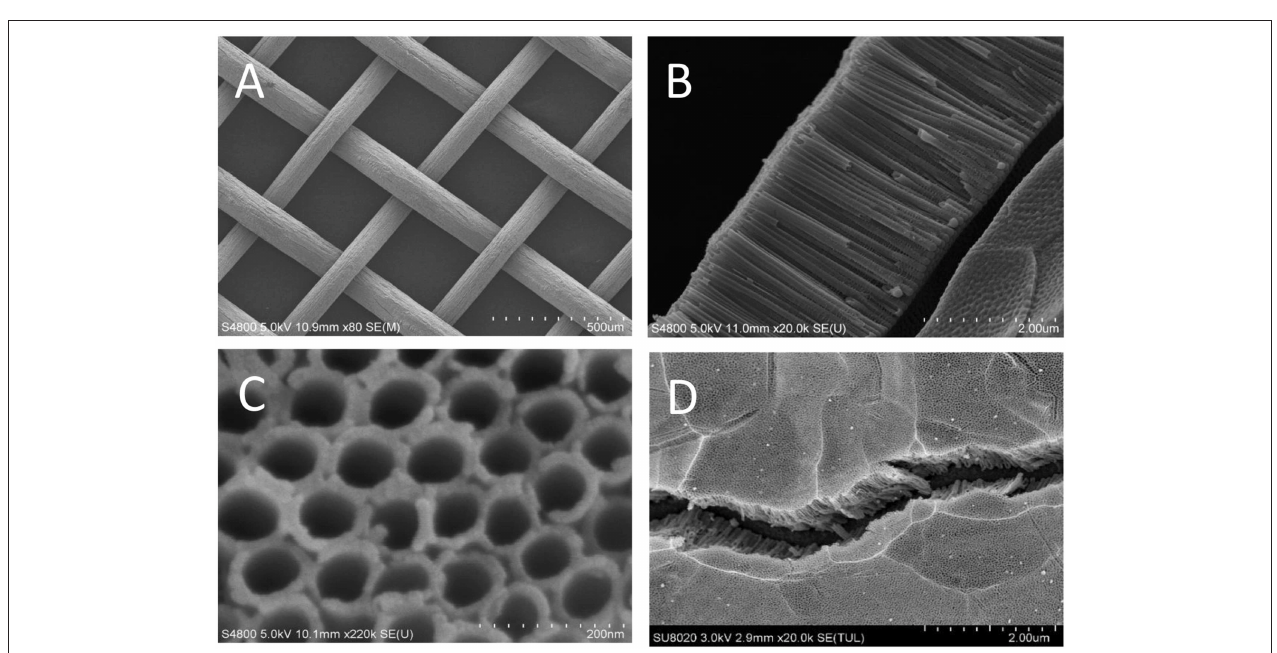
FIGURE 1 | SEM images: (A) Ti meshes, (B) side view and (C) top view of the bare 3D TNTAs, (D) Au-NPs on the bare 3D TNTAs.